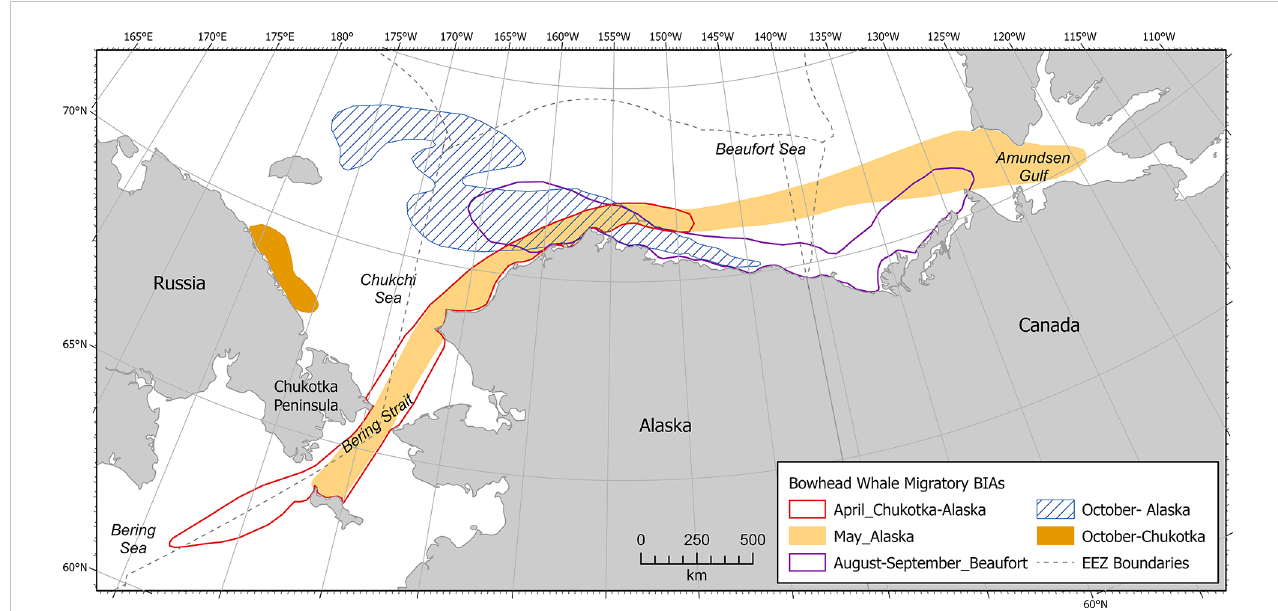
FIGURE 7 Arctic region bowhead whale migratory